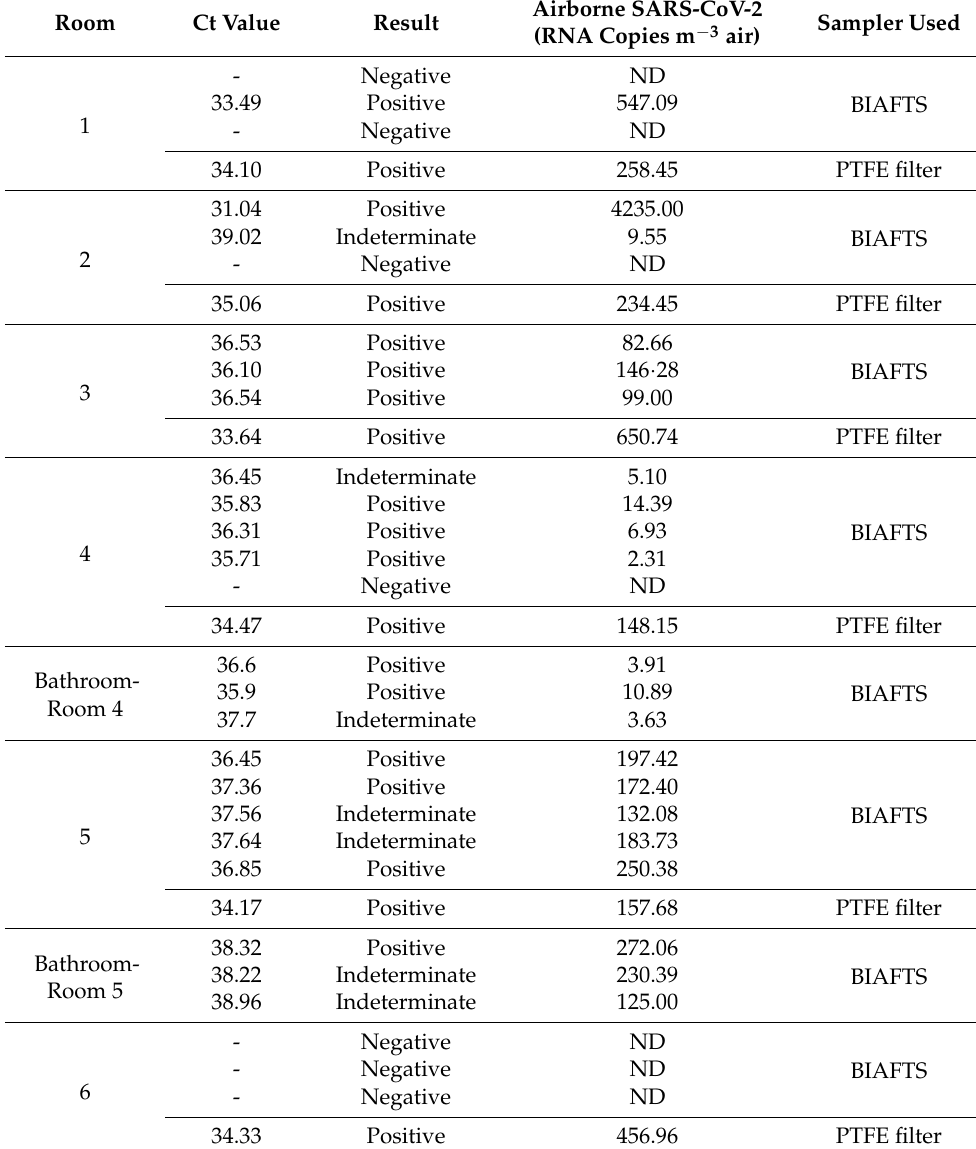
Table 1. RT-qPCR detection of SARS-CoV-2 RNA in aerosols from hospital rooms. The results are presented in RNA copies/m 3 air (N-gene), detection obtained by RT-qPCR, mean Ct from triplicates. Standard curve: y = -3.348 + 38.2; R 2 = 0.987; Efficiency = 98.9%; curve between 2 × 10 3 and 1 copies of synthetic virus RNA per well. Result interpretation as “indeterminate” refers to those samples with Ct > 40 for one of the N-genes (N1 or N2). All BIAFTS samples were taken in 2 min and PTFE filter samples in 1 h 45 min − 2 h (Figure